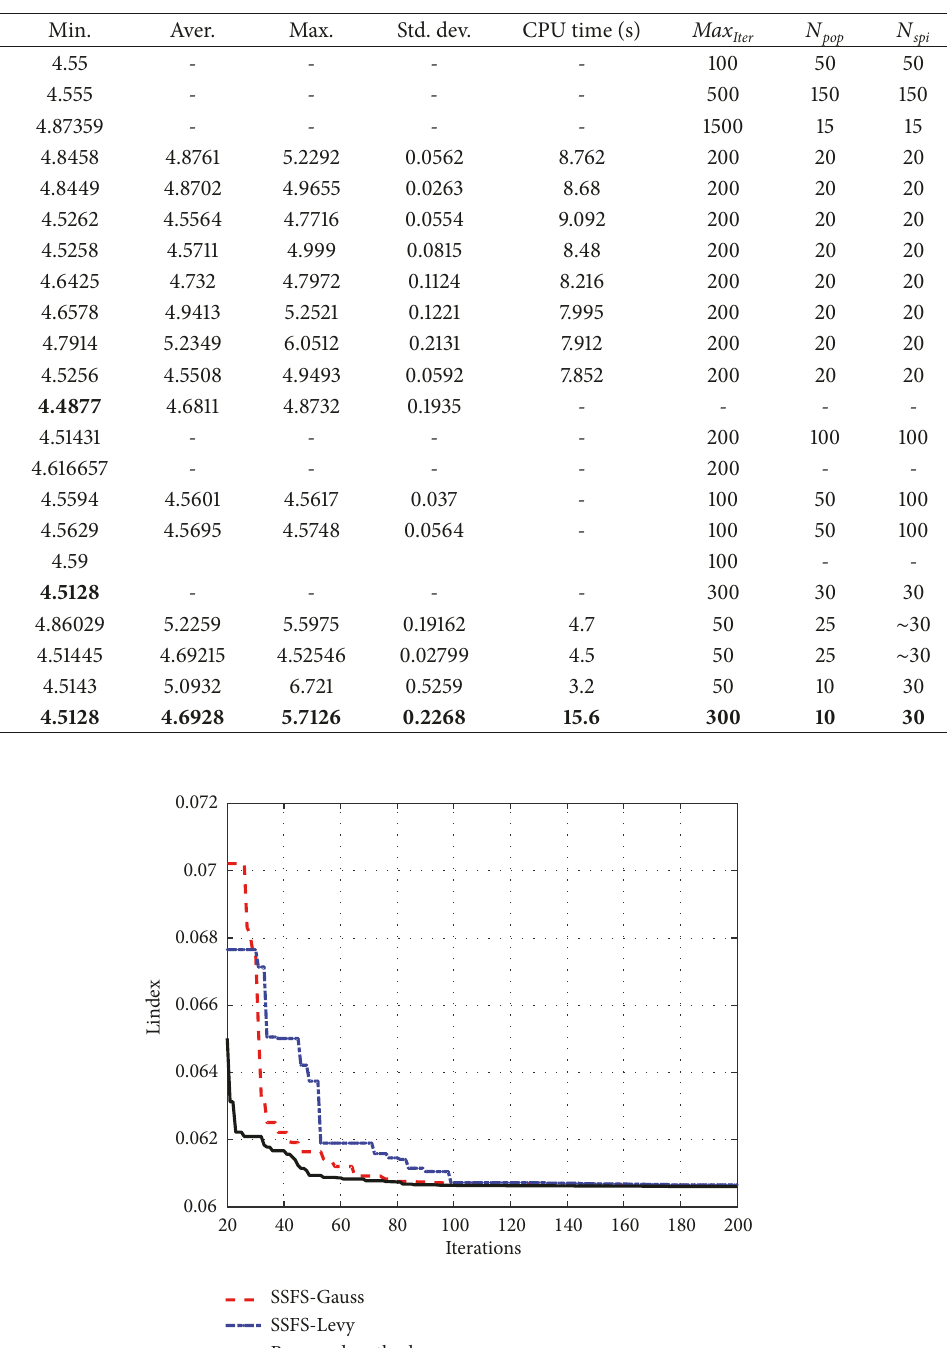
Table 5: Comparison of results obtained from IEEE 30-bus system with power loss optimization.